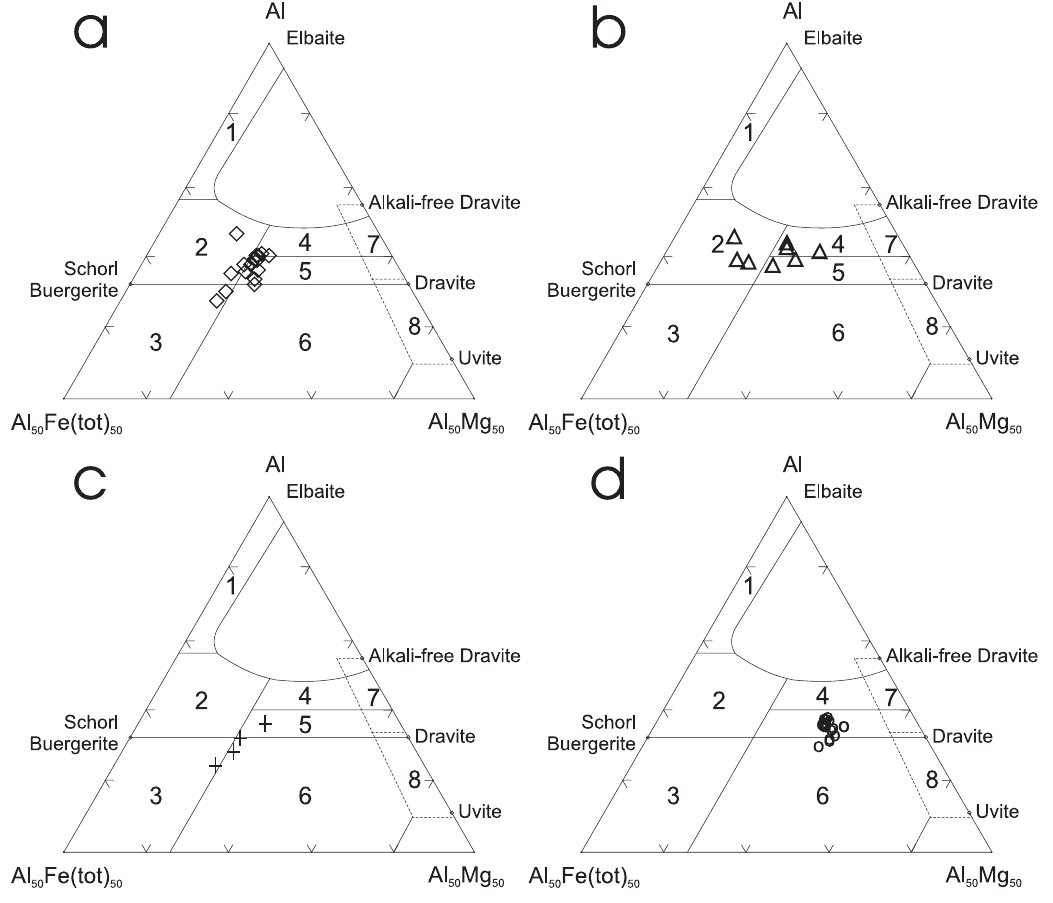
Fig. 3 – Representation of tourmaline compositions in Henry and Guidotti’s (1985) Al-Fe tot -Mg diagram (molecular proportions). Tourmalines from: (a) metachert – Tapera Grande and Quartzito; (b) tourmalinite – Tapera Grande; (c) quartz vein – Tapera Grande, and (d) quartz vein – Quartzito. Fields: (1) Li-rich granitoid pegmatites and aplites; (2) Li- poorgranitoidsandtheirassociatedpegmatitesandaplites; (3)Fe 3 + richquartz-tourmalinerocks(hydrothermallyaltered granites); (4) metapelites and metapsammites coexisting with anAl-saturating phase; (5) metapelites and metapsammites not coexisting with an Al-saturating phase; (6) Fe 3 + rich quartz-tourmaline rocks, calc-silicate rocks, and metapelites; (7) low-Ca metaultramafics and Cr, V-rich metasediments, and (8) metacarbonates and metapyroxenites. Cr (0-0.04) or V